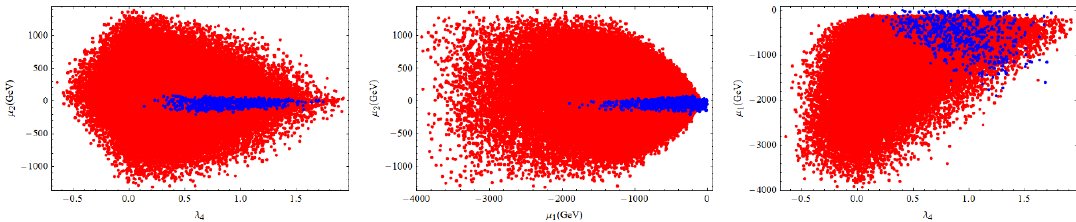
Figure 3 . The SFOEWPT viable points in the parameter spaces of (cid:22) 2 and (cid:21) 4 (left), (cid:22) 2 and (cid:22) 1 (middle), and (cid:22) 1 and (cid:21) 4 (right). The blue and red points satisfy the two step phase transition and one-step SFOEWPT